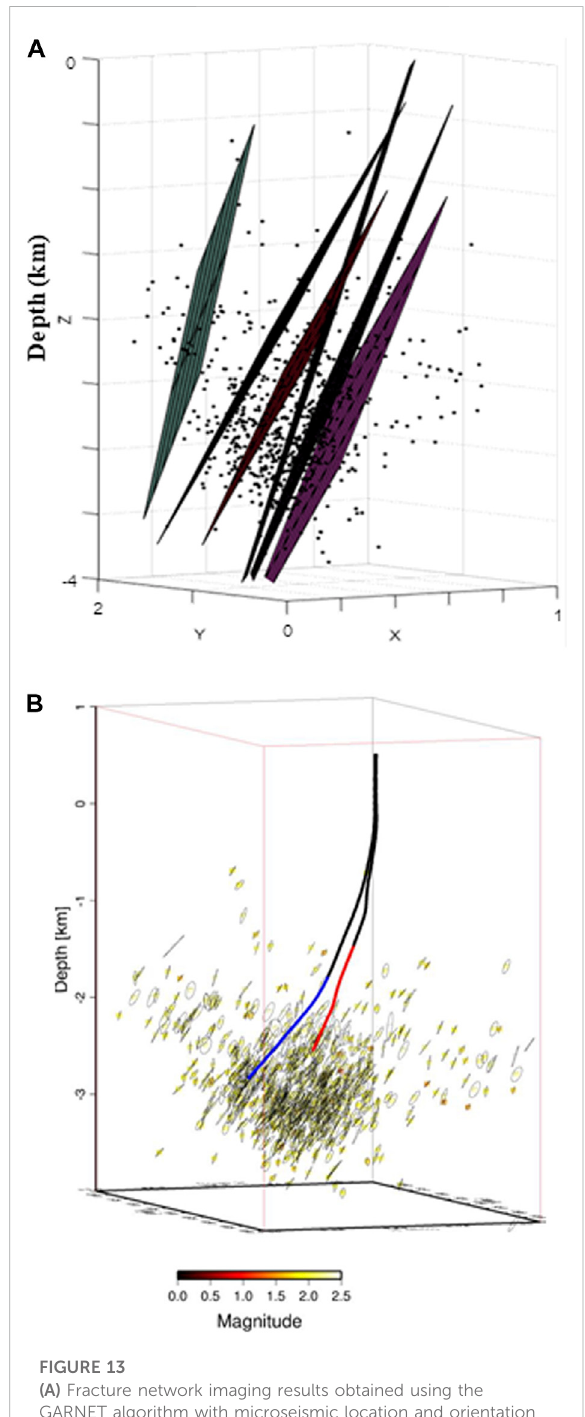
The energy decreased rapidly during the iteration, and the optimal fracture model planes were estimated through energy minimization within three iterations (Figure 11B). These synthesis